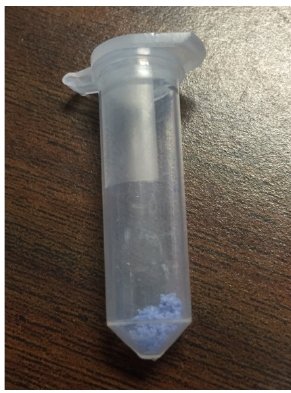
Figure 1. Dried CuHARS product. CuHARS was synthesized and dried as indicated in Section 2. A yield of 5 mg of blue product is shown in the bottom of a 2 mL plastic tube.